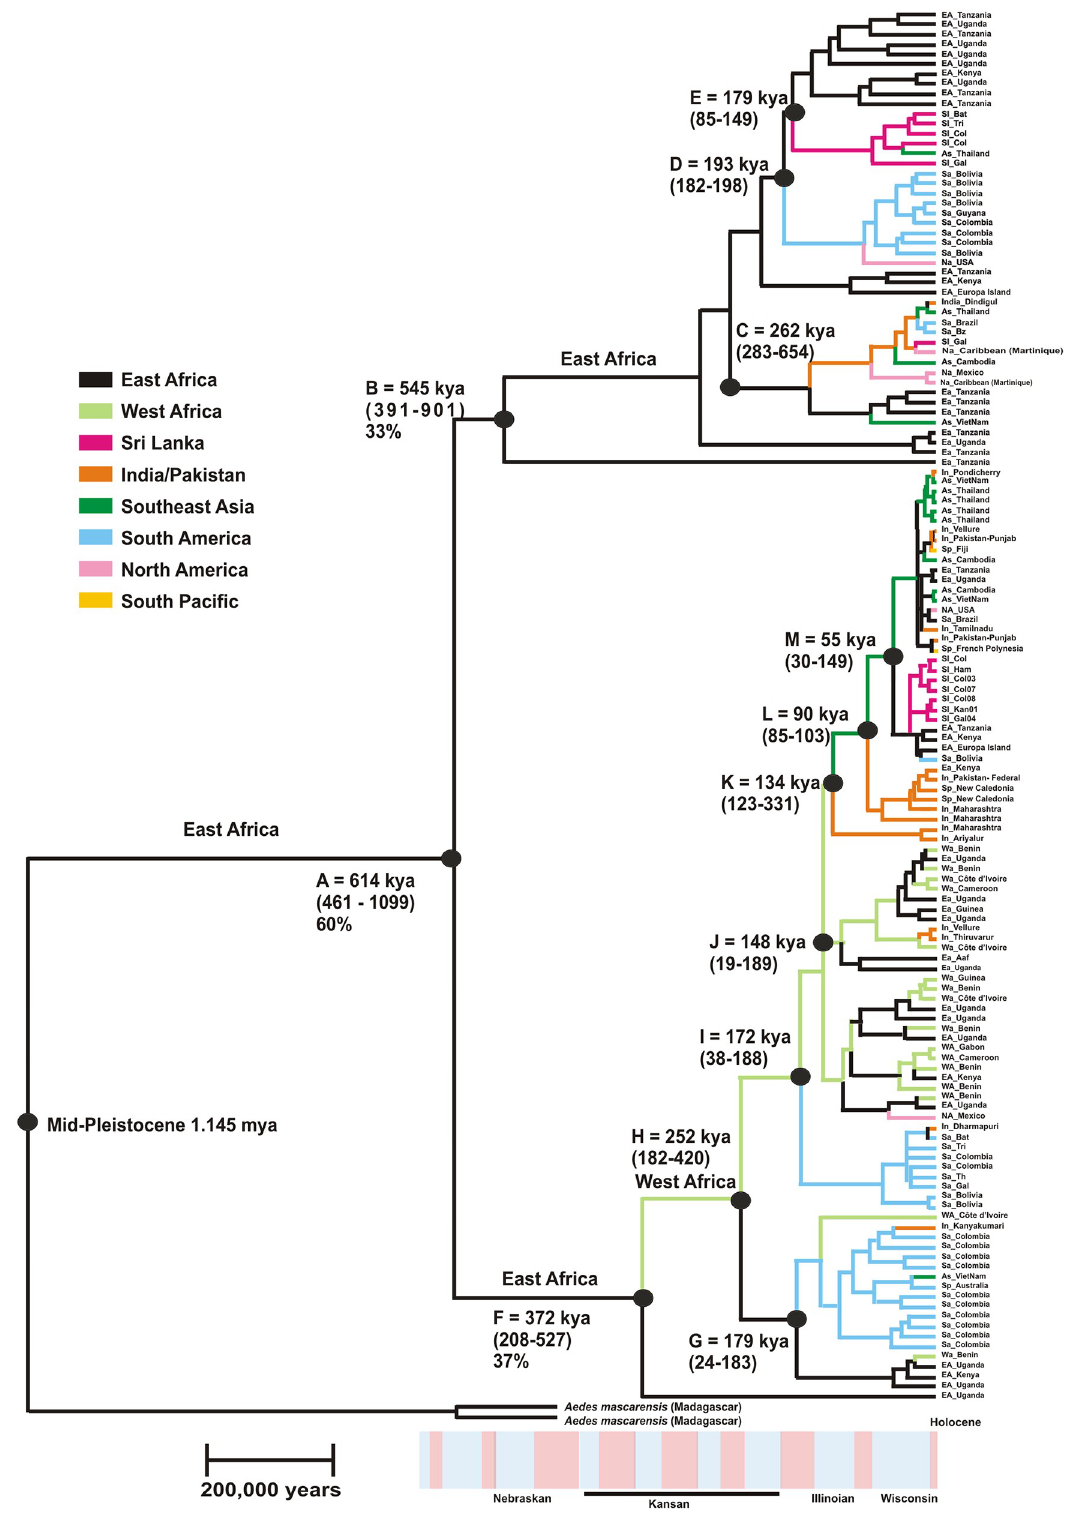
Fig 4. Phylogeographic analysis of the CO1 gene followed the Bayesian phylogeographic model implemented in BEAST2 [46] v. 2.4.8. The alignment file was converted to an � .xml file using BEAUti following the example provided by Taylor (https://math.la.asu. edu/~jtaylor/teaching/ICEMR2014/geographical_analysis.pdf). Sequences were partitioned into 8 geographic regions. A scale corresponding to 200,000 years is provided at the base. The identity of nodes appears in the text. https://doi.org/10.1371/journal.pone.0235430.g004 PLOS ONE | https://doi.org/10.1371/journal.pone.0235430 July 28,